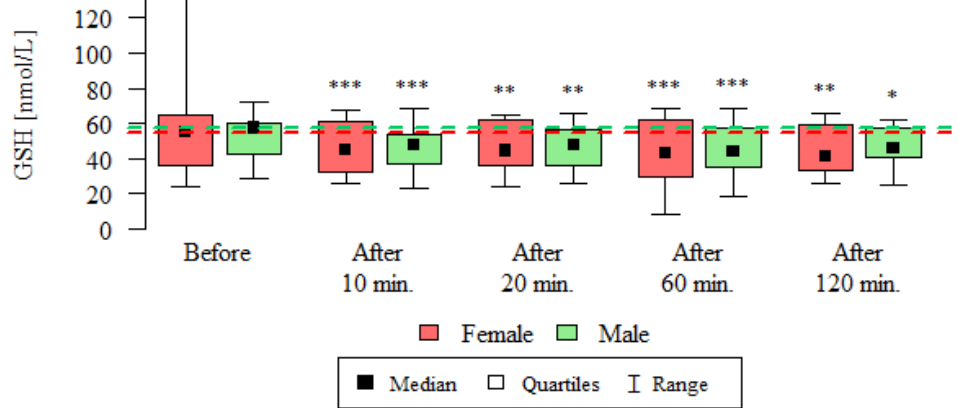
Figure 2. CAT activity [U/g Hb] in the blood of subjects undergoing routine HRCT examination before the test, 10 min, 20 min, 60 min and 120 min after the test. The analysis was carried out using the Wilcoxon test for dependent (repeated) measurements; the graph shows the medians, quartiles and ranges of values of individual variables. * p — comparison with the measurement before the examination (* p < 0.05, ** p < 0.01, *** p < 0.001) — Wilcoxon test for dependent (repeated) measurements.